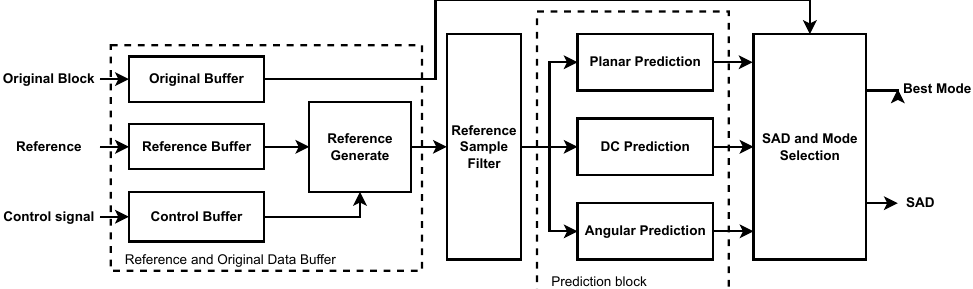
Figure 5. The proposed hardware architecture for H.265/HEVC intra prediction.